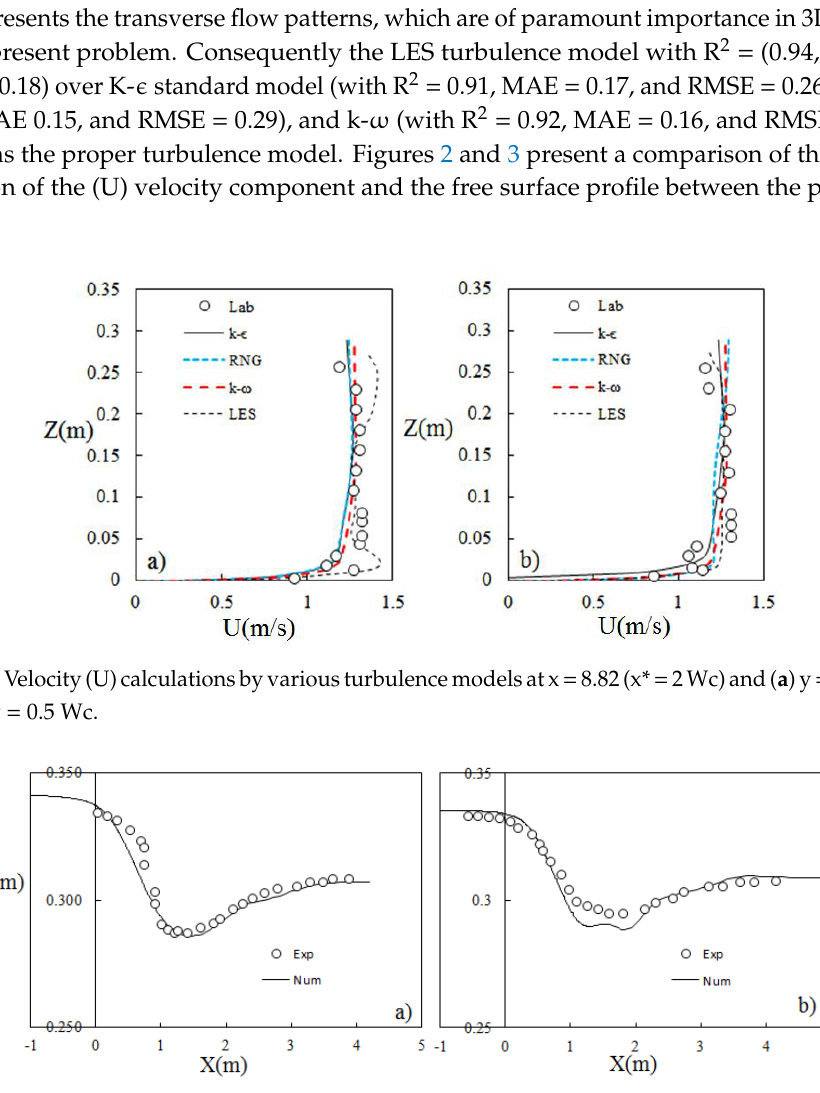
Figure 3. Comparison of measured with large-eddy simulation (LES)-simulated flow surface in a ) y/W = 0.167 and b ) y/W = 0.5.